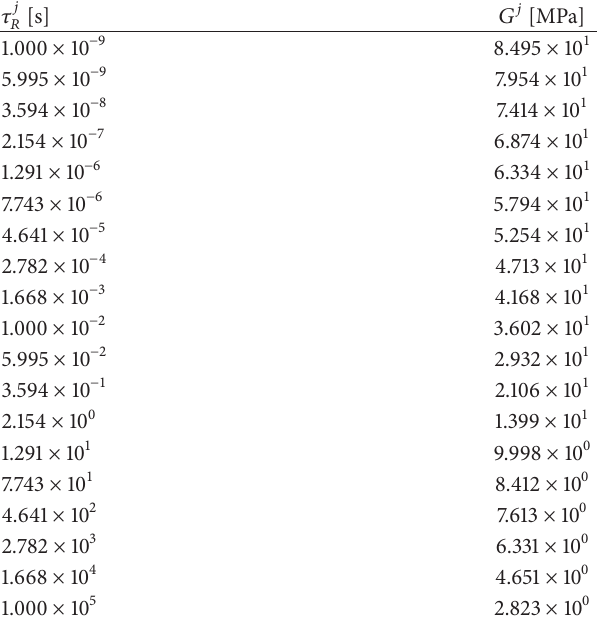
Table 1: Generalized Maxwell model relaxation times 𝜏 associated shear moduli 𝐺 𝑗 for